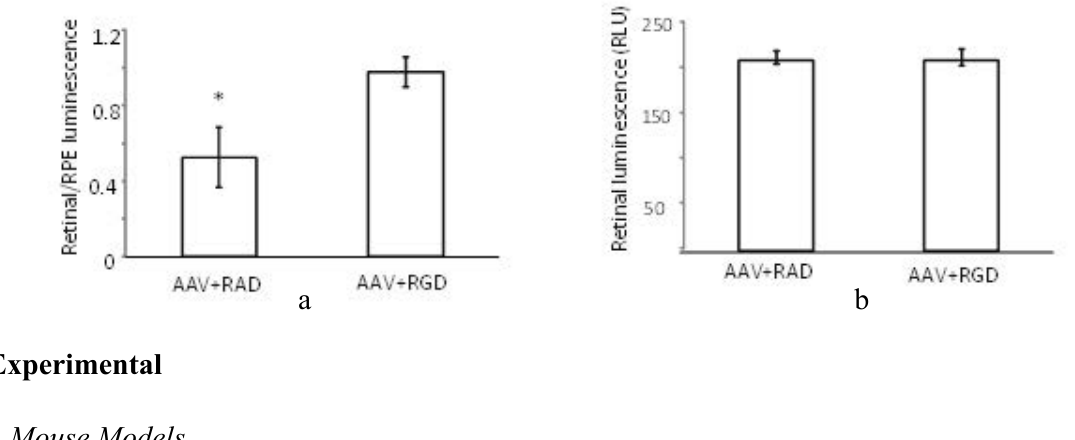
Figure 7. Effect of peptides on luminescence profile following co-subretinal injection with AAV2/1(CMV-luciferase) in WT mice (n = 8). While the ratio (retinal luminescence)/ (RPE luminscence) is higher for RGD co-injected mice, ( a , p = 0.017), the absolute retinal luminescence ( b ) suggests that the RPE-blocking effect is not improving retinal